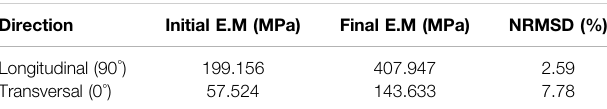
TABLE 2 | The table shows the results of the un fi tted experimental elastic properties and the fi tted elastic properties obtained from the tensile test and their respective fi t.